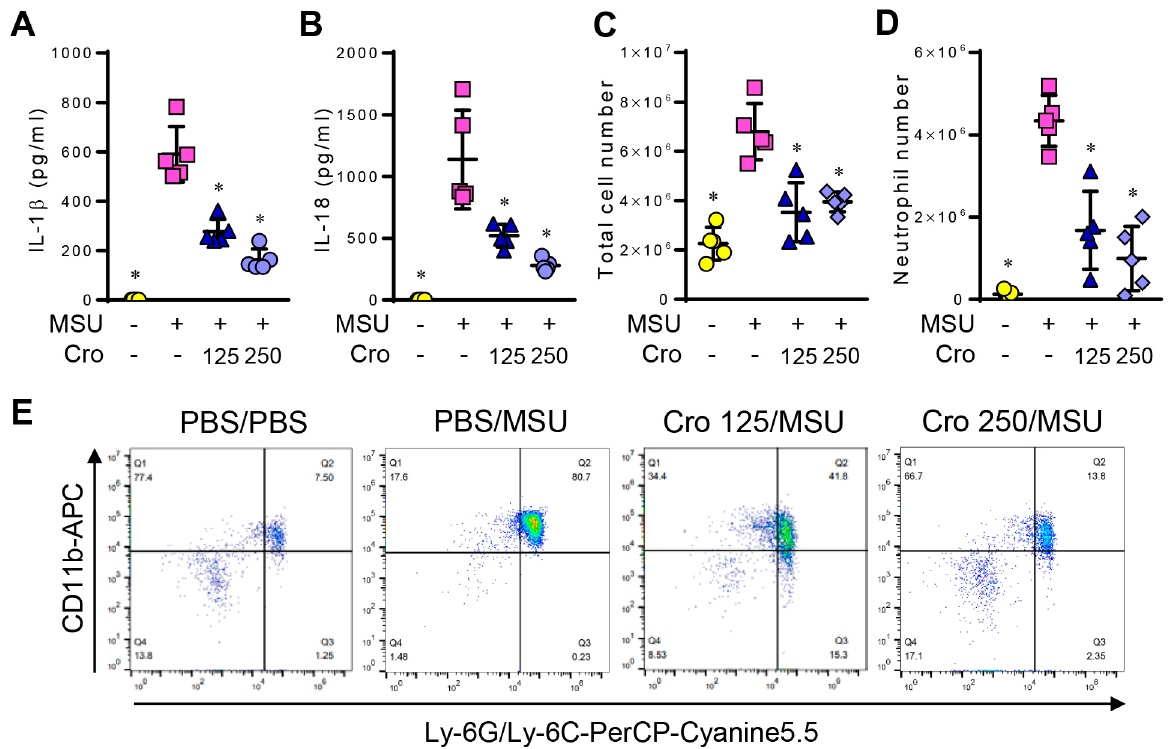
Figure 7. Suppressive effects of Crocin on MSU-induced peritonitis. C57BL/6 mice were intraperi- toneally injected with Crocin (125 mg/kg or 250 mg/kg). After 2 h, peritonitis was induced by intraperitoneal injection with MSU (2 mg) for 6 h. ( A ) IL-1 β , ( B ) IL-18, ( C ) Total cell number, and ( D ) Neutrophil number from peritoneum exudates. The data are expressed as the mean ± SEM. Each group had five mice. ( E ) Representative flow cytometry histograms. * p < 0.05 vs. the group injected with MSU.